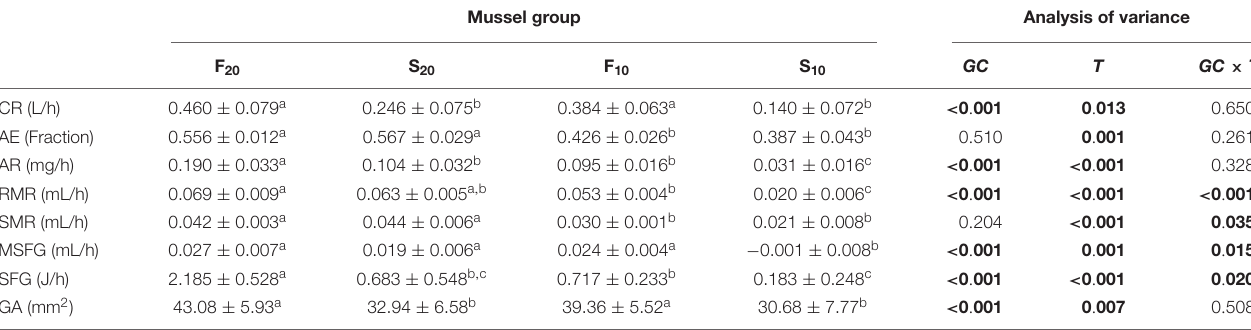
TABLE 4 | Physiological parameters determining the energy budget and gill surface area (GA, mm 2 ) in mussels maintained at 10 and 20 ◦ C. Mussel group Analysis of